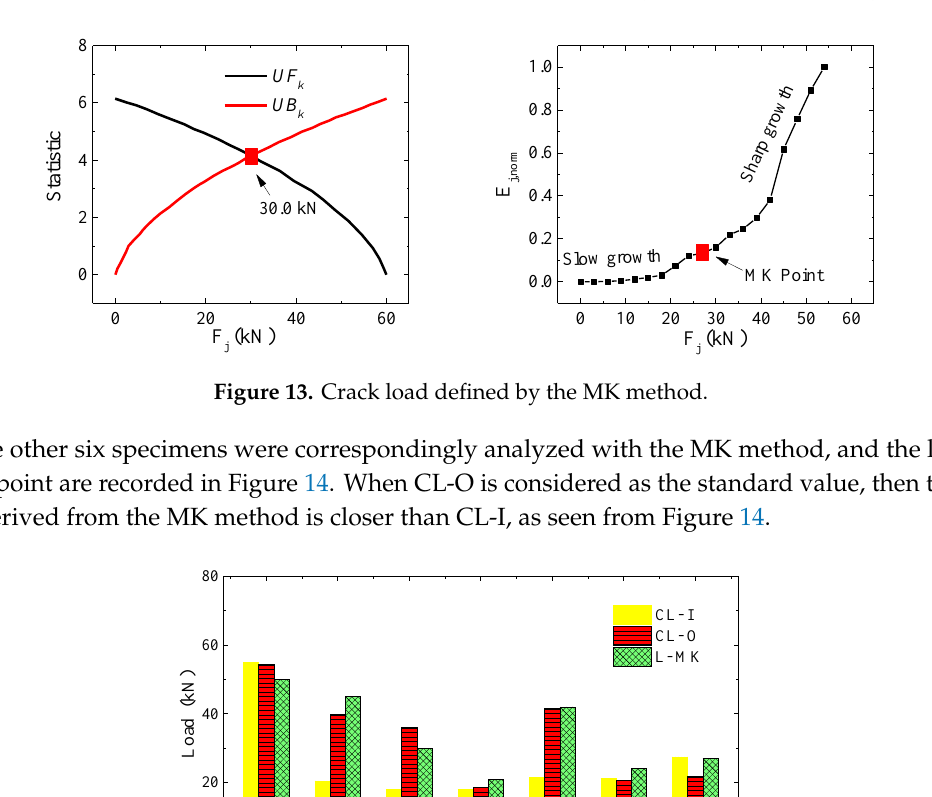
Figure 15. The changing features of strain-based stressing state modes for specimen 1-3.